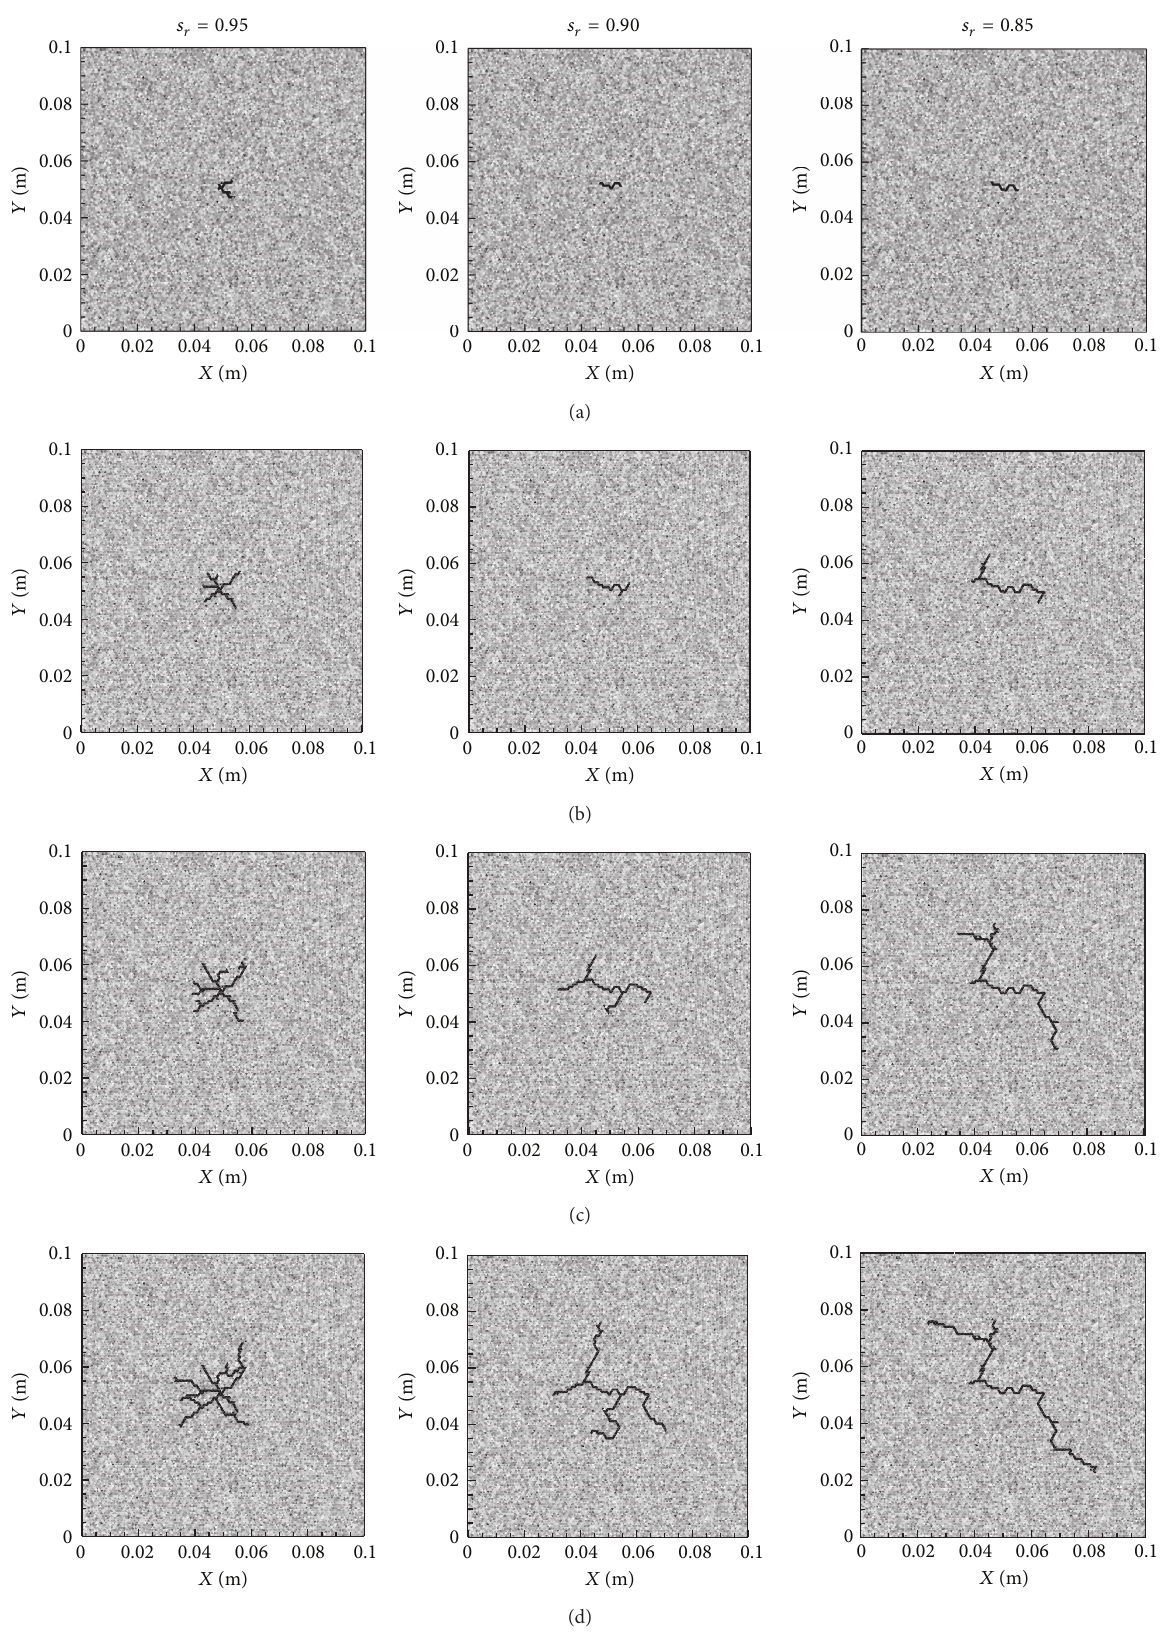
Figure 5: The simulated fracture propagation process at different saturations arranged in